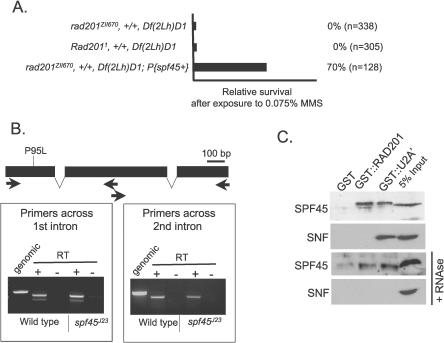
Genetic and Physical Interactions between SPF45 and RAD201, a Member of the RecA/Rad51 Protein Family(A) spf45J23 does not complement the MMS mutant phenotype of rad201. Relative survival to adulthood of the double heterozygous mutant animals was assessed by comparing the number of experimental animals with the number of sibling controls.(B) rad201 splicing in wild-type and spf45J23 mutants. Genomic organization of rad201 (CG2412). The position of the C-to-T transition leading to a proline-to-leucine change at position 95 in the rad2011 open reading frame is indicated. The rad201 gene encodes a single transcript. RT–PCR analysis using primers that span the first and second introns demonstrates that splicing is unaffected in spf45J23 mutants.(C) RAD201 interacts with SPF45 in whole-cell extracts in an RNA-independent manner. The ability of RAD201 to associate with SPF45 in whole-cell extracts was tested by GST pull-down assays followed by Western blotting. GST::RAD201, GST::U2A′, or GST alone, bound to glutathione sepharose beads, were incubated with extracts made from wild-type or spf45J23 embryos, followed by Western blotting using an antibody directed against SPF45 or SNF. The lane marked 5% input is a control in which the amount of extract corresponds to ∼5% of the material applied to the glutathione affinity beads. The RNase sensitivity of these interactions was tested by pretreating the extracts with a combination of RNase A and RNase T1.